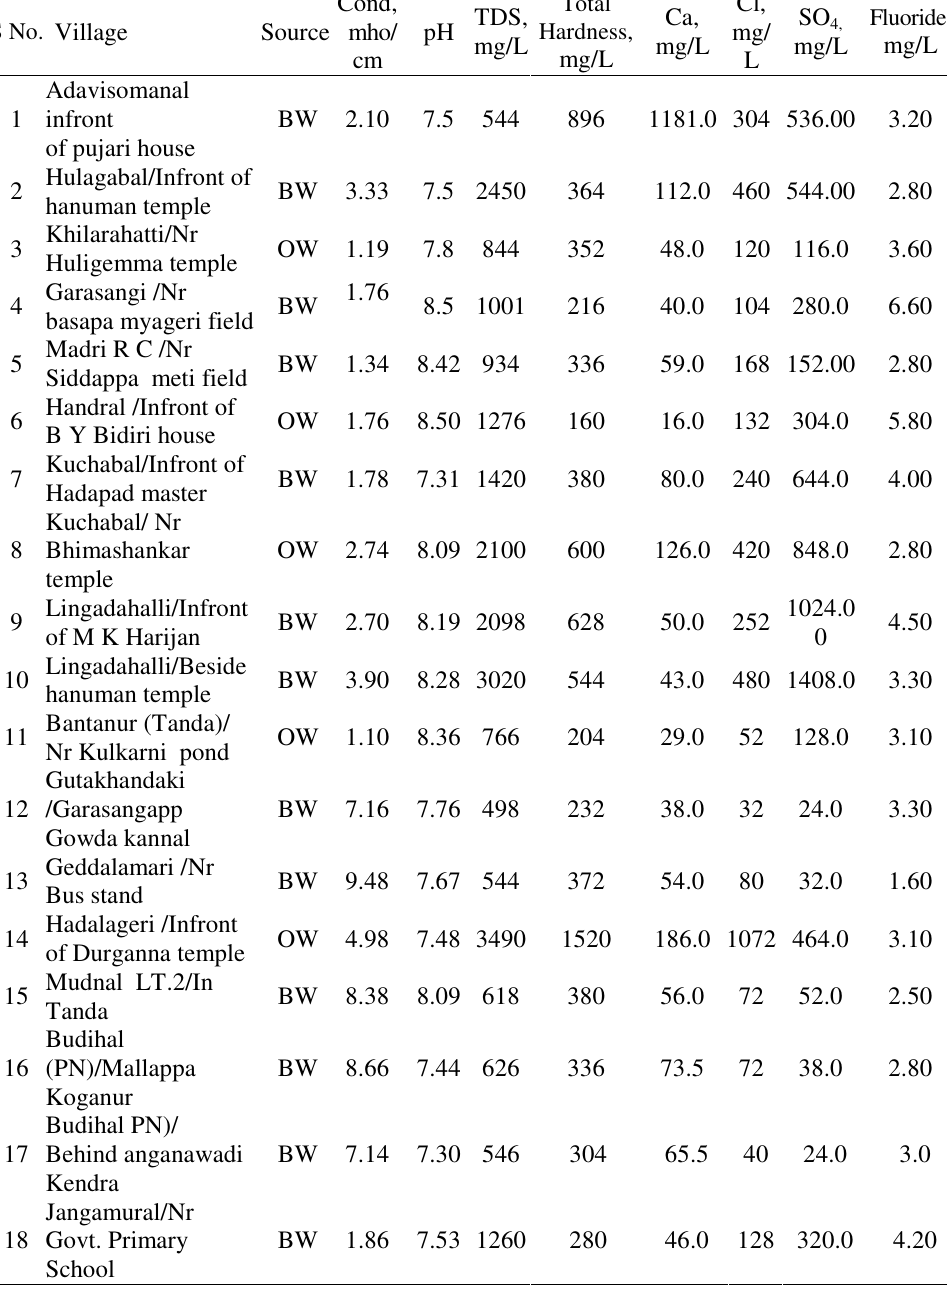
Table 2. Physicochemical characteristics of water quality in selected villages of Muddebihal